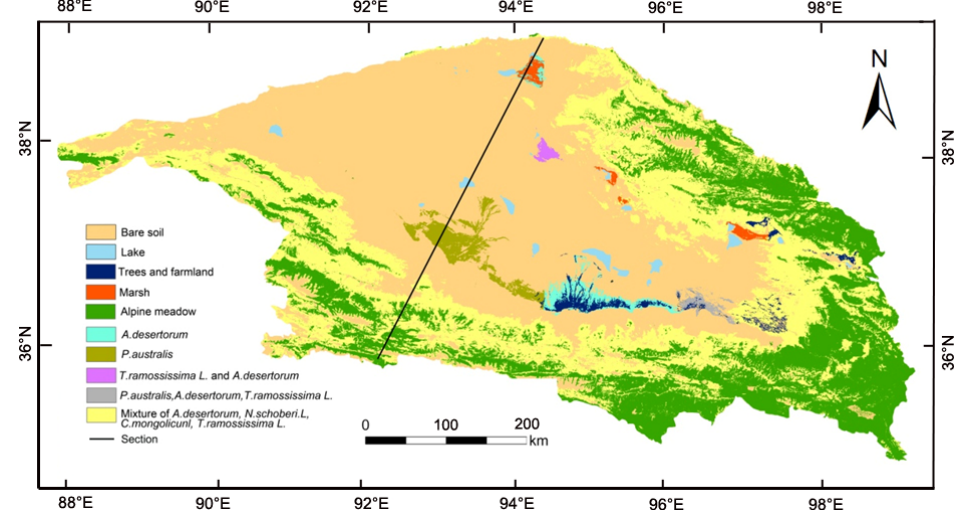
Figure 9. Land cover and vegetation types of Qaidam Basin in 2011. The black solid line represents a section from north to